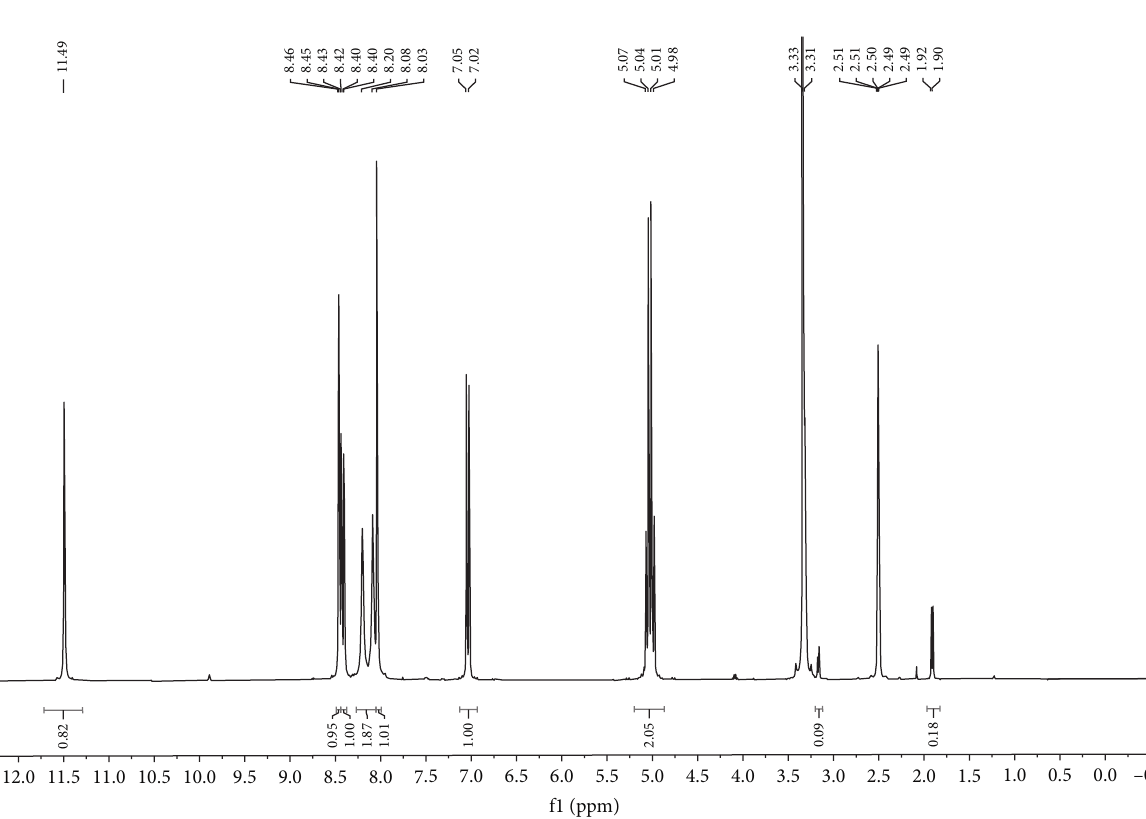
Figure 1: 1 H-NMR spectrum of compound 1